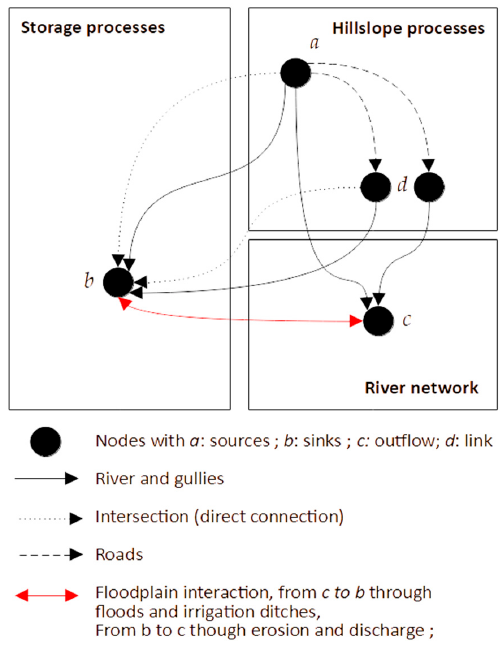
Figure 8. Oriented graph detailing sediment connections from source to sink. Table 1. Connection types in the study area.